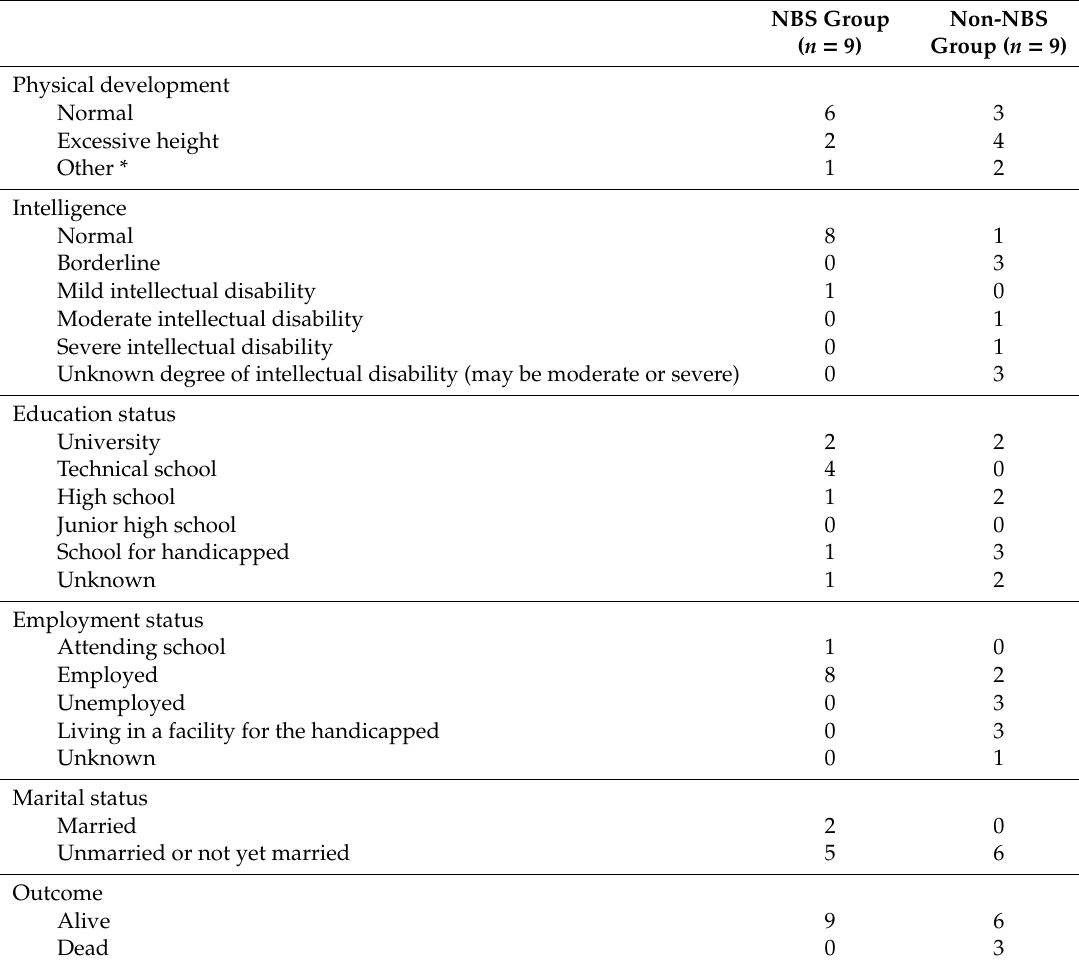
Table 3. Comparison of clinical and social